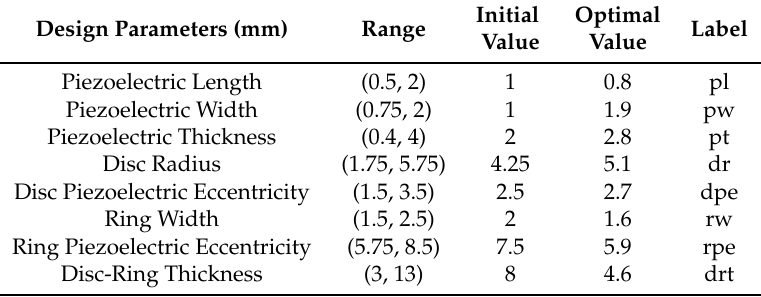
Table 6. Optimized transducer, along with assumed ranges and the initial values of